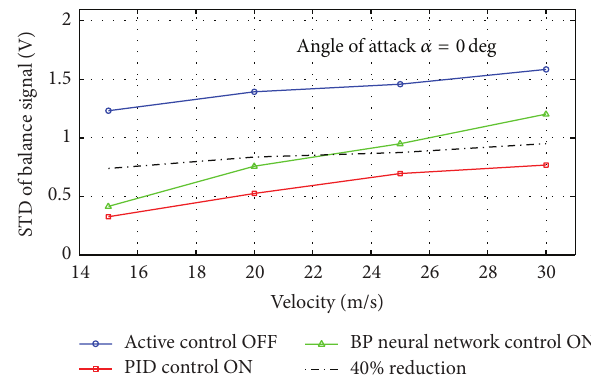
Figure 17: Pitch performance of active damper with model at 𝛼 = 0 , balance signal STD versus velocity with active control